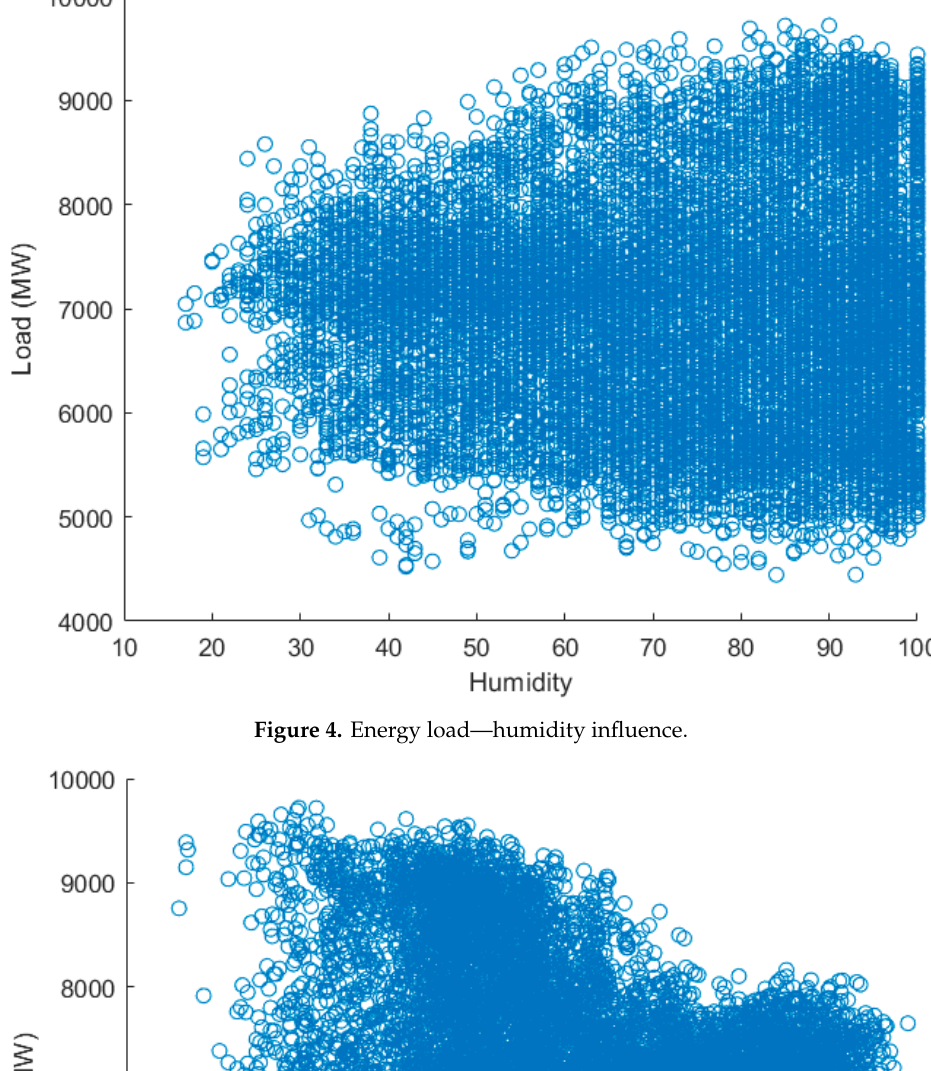
Figure 4. Energy load—humidity influence. 2